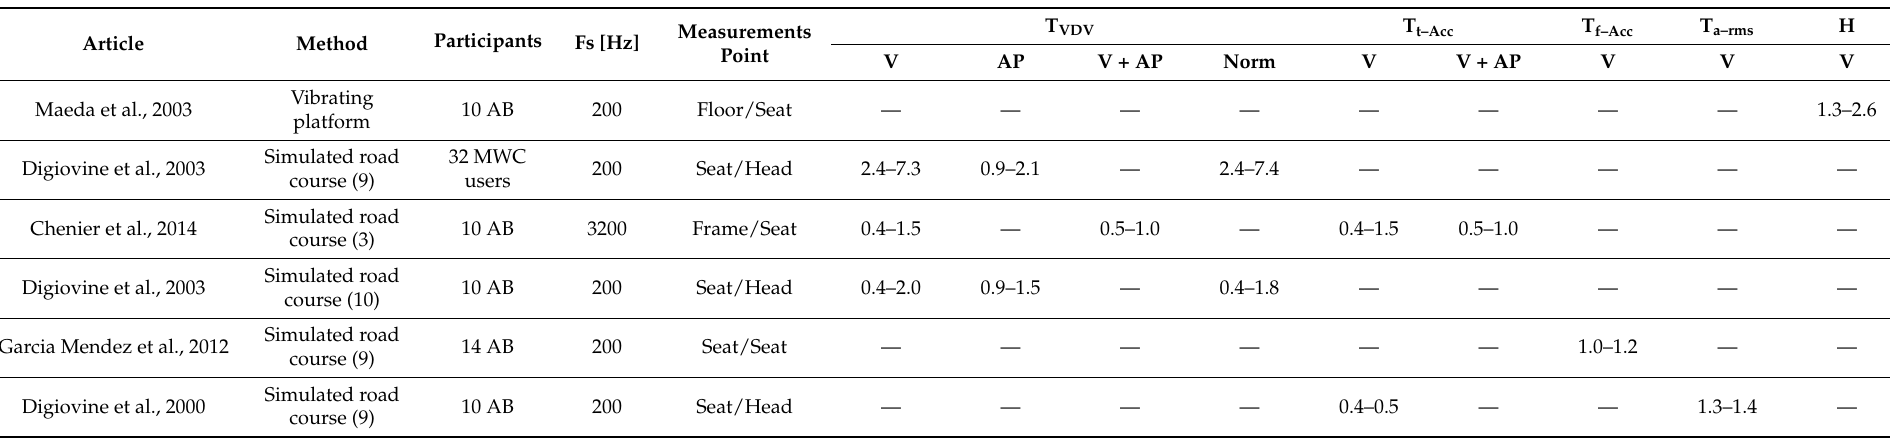
Table 5. Summary table of reviewed studies regarding investigation vibration